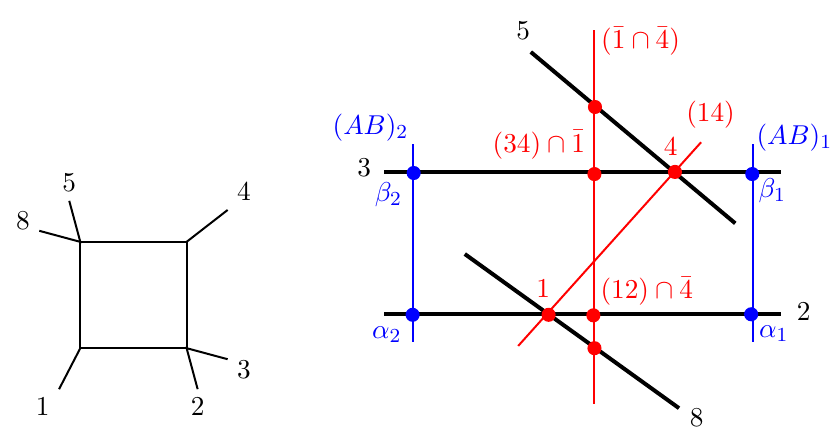
Figure 2 . Two-mass-easy configuration (left) and four intersections on (12) or (34) (right); the black lines (81) , (12) , (34) and (45) form a two-mass-easy Schubert problem, whose solutions are the red lines, intersecting (12) (as well as (34) ) at two points. The blue lines are solutions from the four-mass Schubert problem